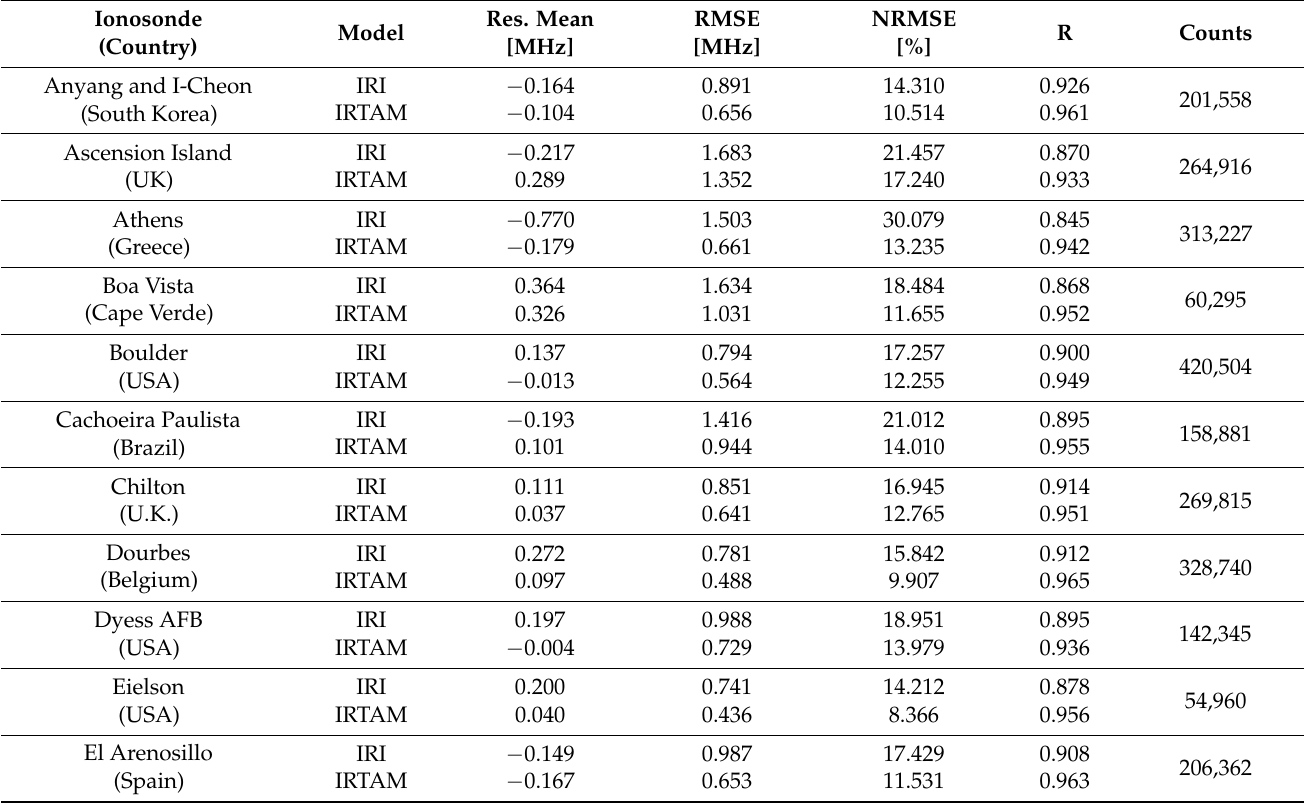
Table 3. Same as Table 2, but for each of the fo F2 datasets relative to the 40 ionosonde stations listed in Table